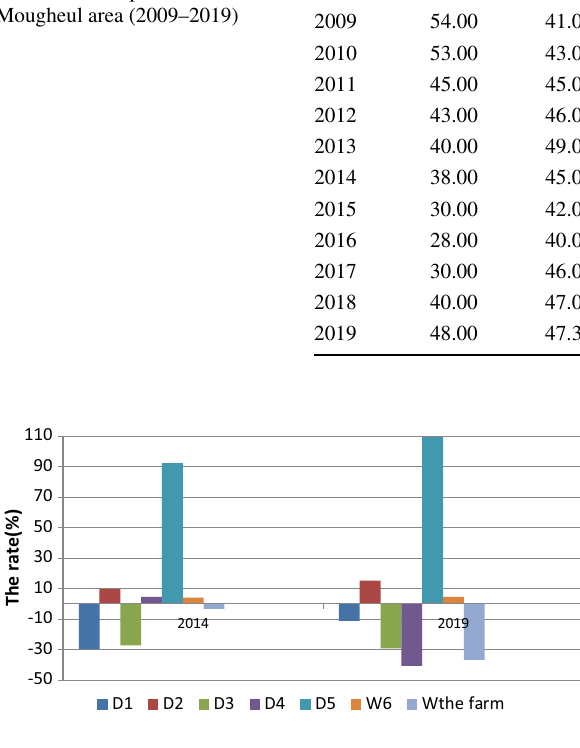
Fig.9 The rate of change in Mg +2 between 2014 and 2019